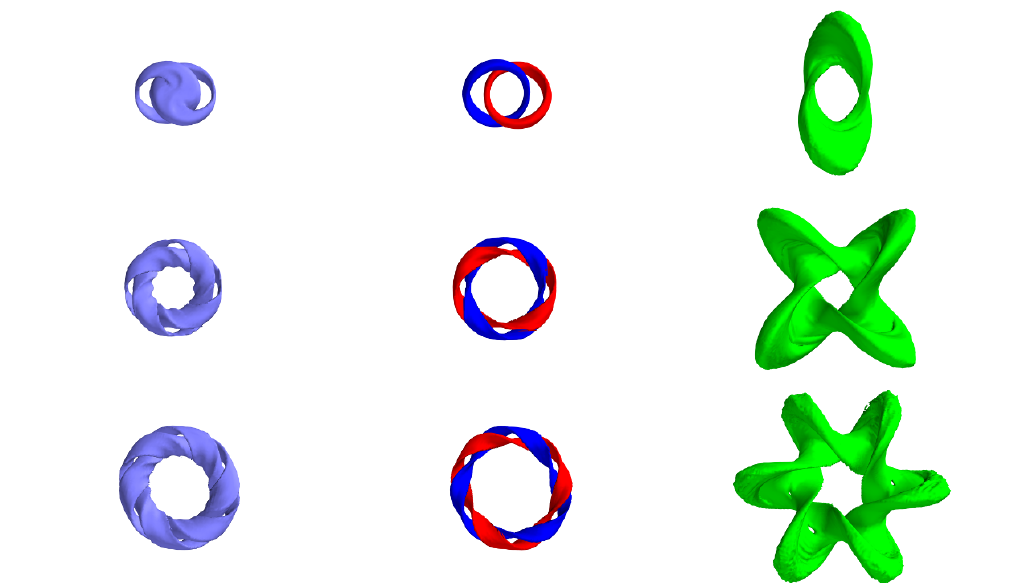
Figure 8 . Isosurfaces showing the energy density distributions E = 40 ((cid:12)rst column), the (cid:12)eld components (cid:30) 1 = (cid:6) 0 : 9 (second column) and (cid:30) 3 = (cid:0) 0 : 8 of the Q = 1 ; 2 ; 3 \compact" Hop(cid:12)ons ((cid:12)rst, second and third row respectively) in the model (2.1) with potential V = m 2 (cid:30) 2 c 4 = 1 and m =